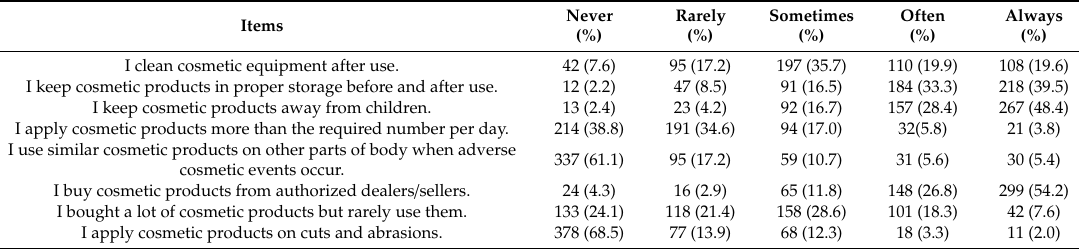
Table 8. Response of participants to the questions on practices towards